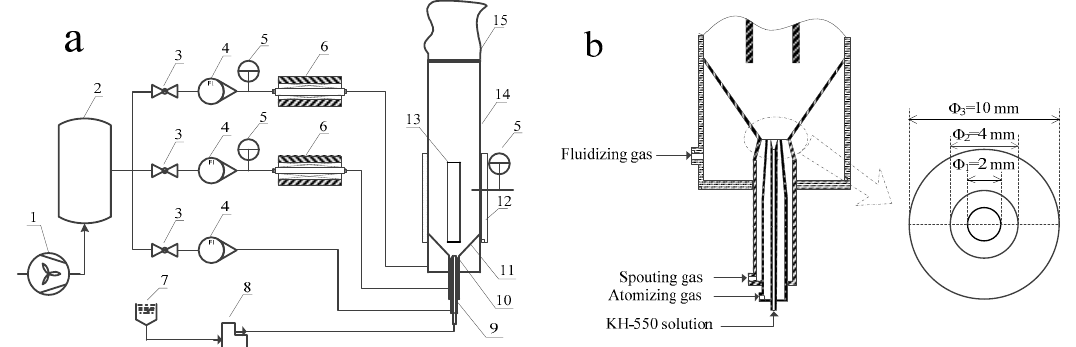
Figure 2. ( a ) Flow chart of the experiment apparatus, ( b ) Atomizer and spout gas inlet. 1. Root blower, 2. Buffer tank, 3. Pilot valve, 4. Rotameter, 5. Temperature controller, 6. Preheater, 7. Storage tank, 8. Peristaltic pump, 9. Annular jet nozzle, 10. Spouted inlet, 11. Distribution plate, 12. Heater band, 13. Draft tube, 14. Spout-fluid bed, 15. Bag-type dust remover.